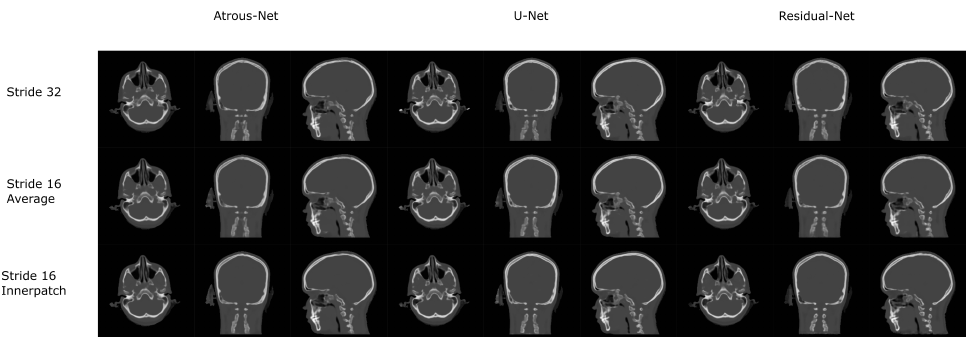
Figure 10. Comparison between the reconstruction method proposed.